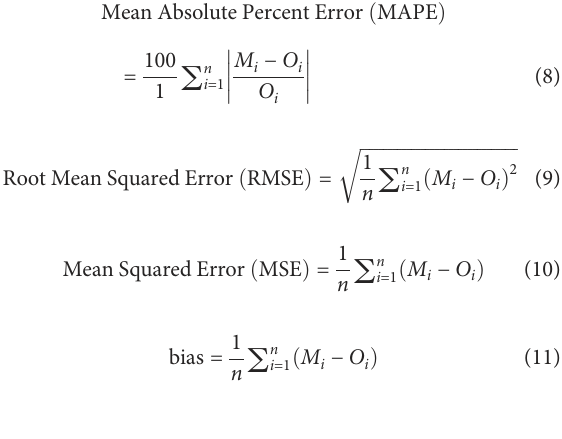
TABLE 2 ( A ) Equations used to relate CDOM optical properties to DOC concentrations (mg L -1 ) and the coef fi cients derived from the fi tting routines where a CDOM (412), a CDOM (275), and a CDOM (295), refer to the absorption of CDOM (m-1) at 412, 275, and 295 nanometers (nm) respectively.